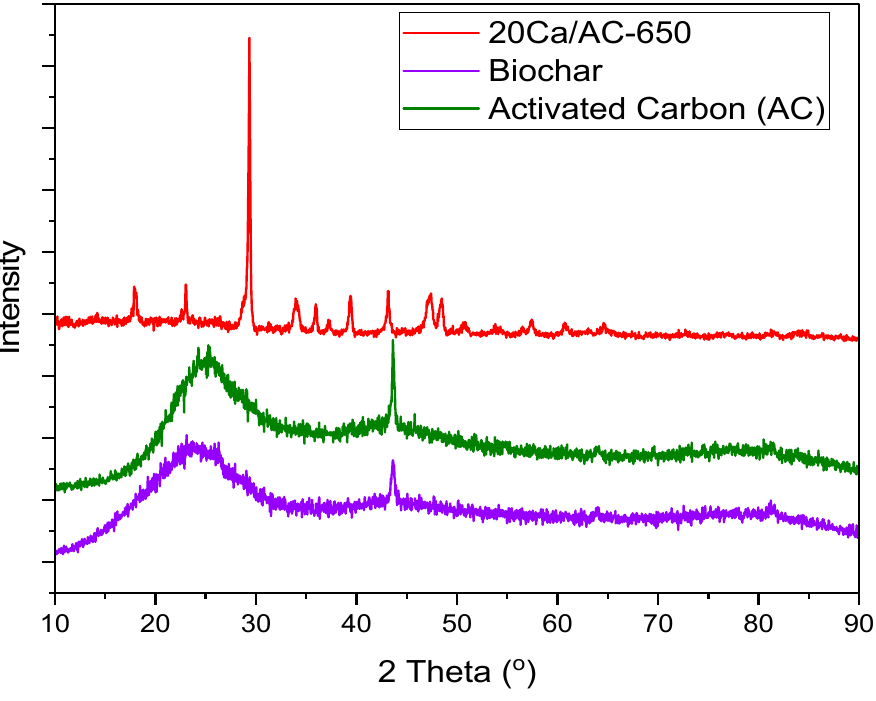
Figure 1. XRD patterns of Biochar, Activated Carbon, and 20Ca/AC-650.